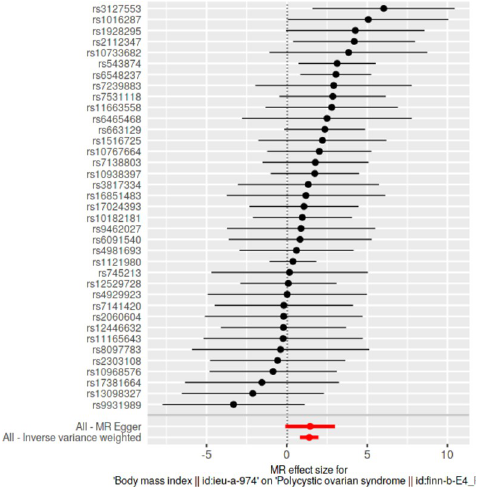
Fig 6. Forest plot of body mass index, against polycystic ovarian syndrome as the outcome. Effects of individual SNPs and pooled estimates from MR-Egger- and inverse variance weighted methods are visualized.